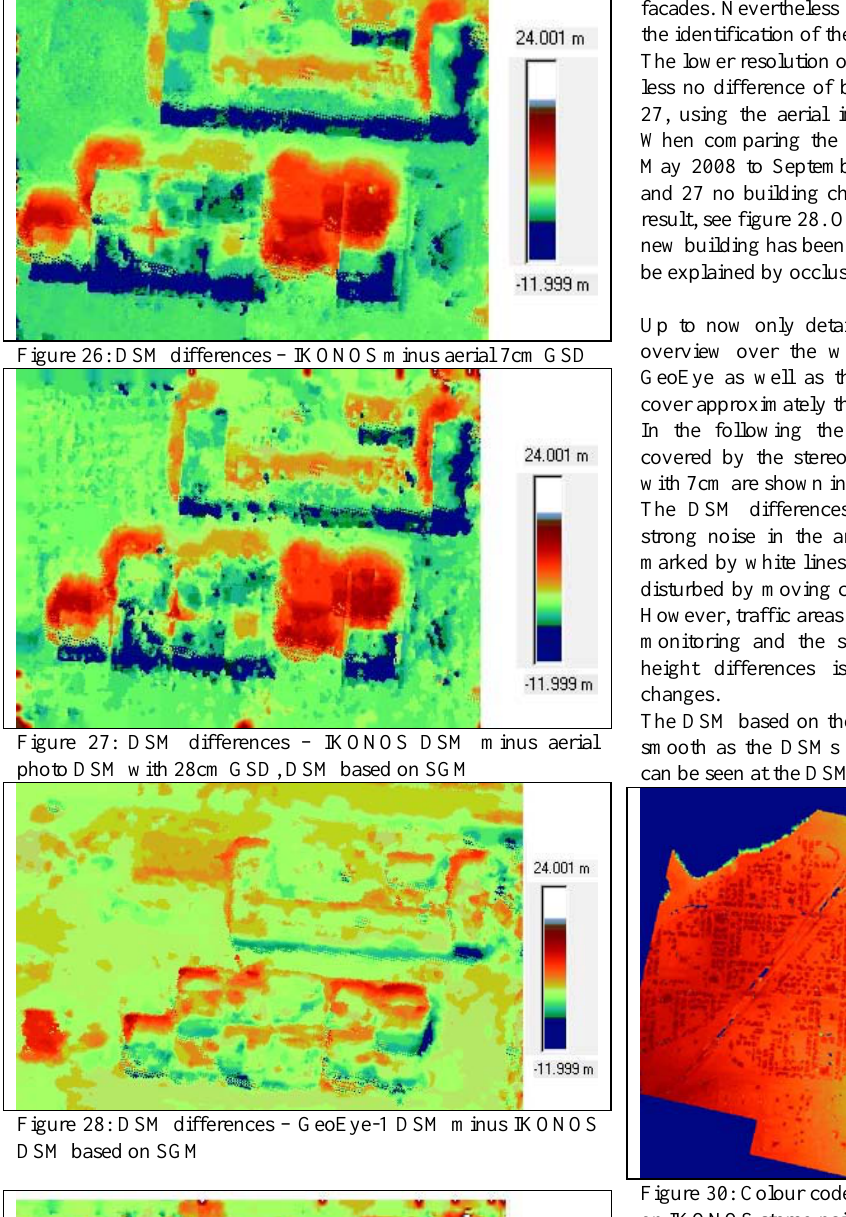
Figure 30: Colour coded DSM by LSM of the whole area